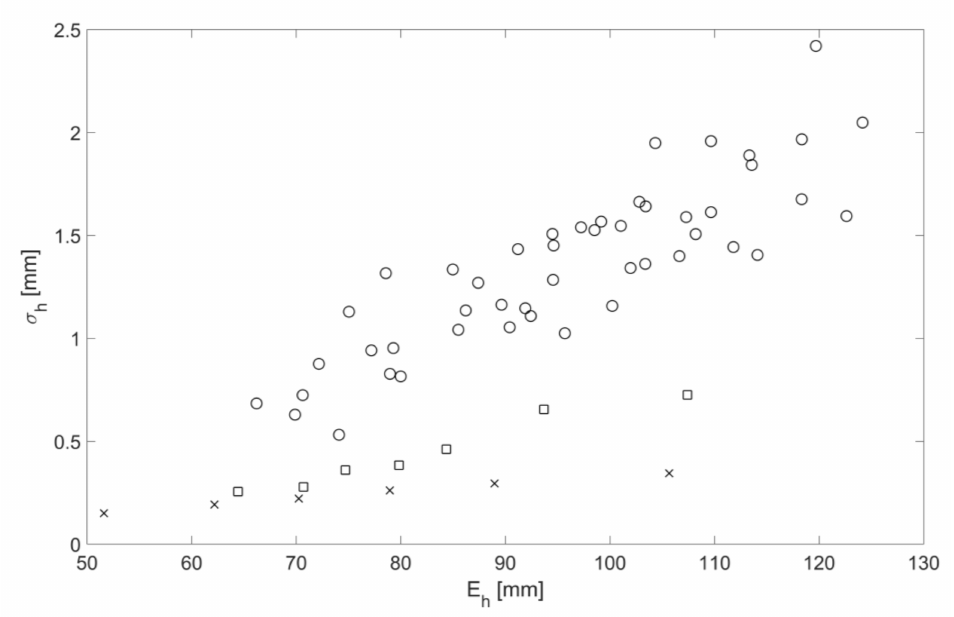
Figure 8. Mean free surface roughness height as a function of mean flow depth for three bed roughness types: clean pipe (cross), pipe with mesh (squares), pipe with spheres (circles).